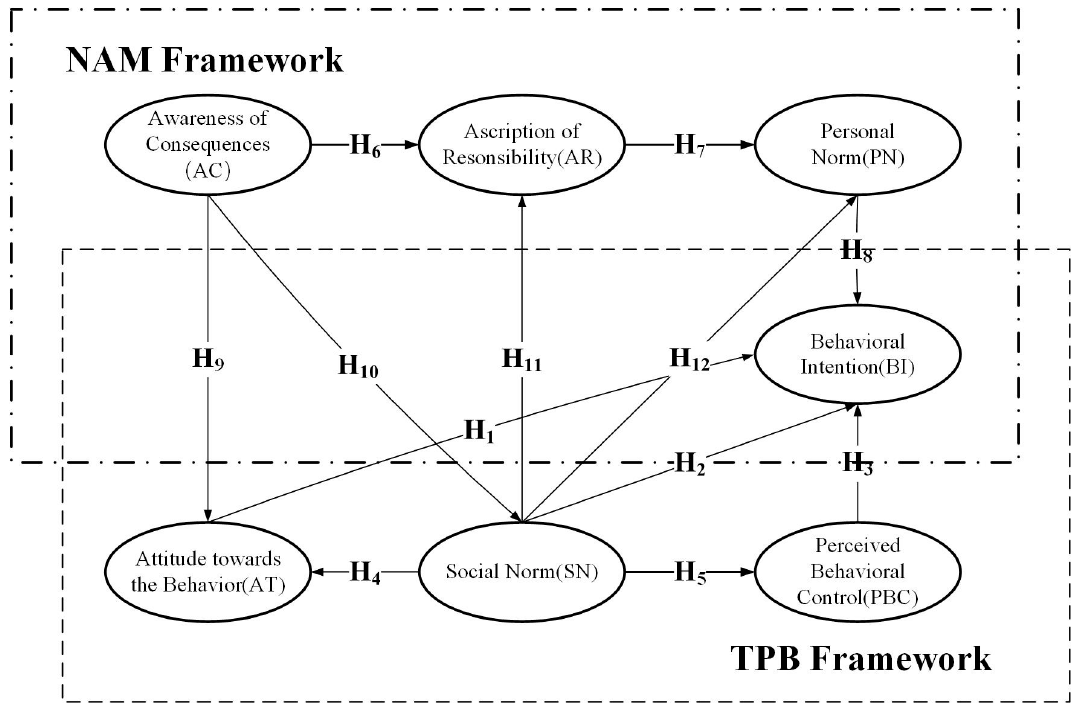
Figure 1. Theoretical analysis framework.